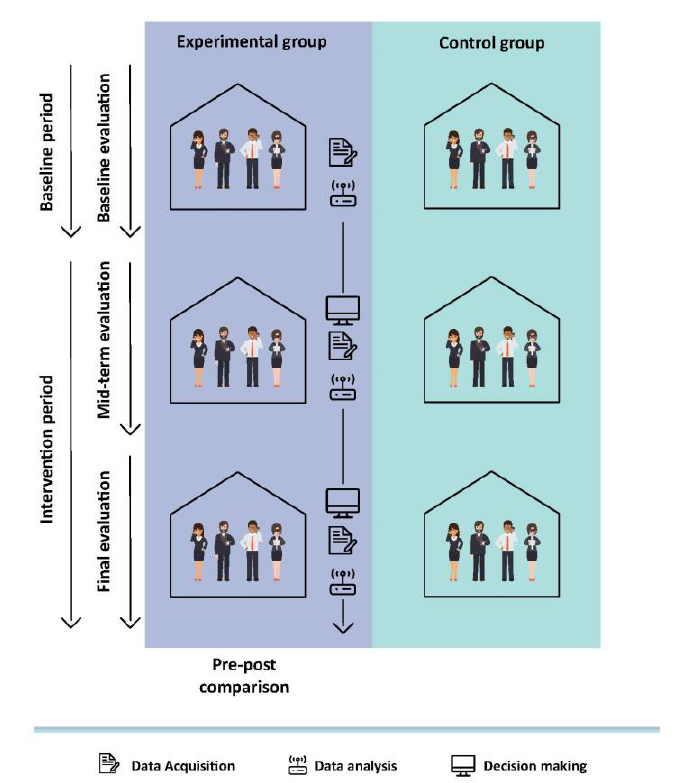
Figure 7. The case study population is divided into experimental and control group.